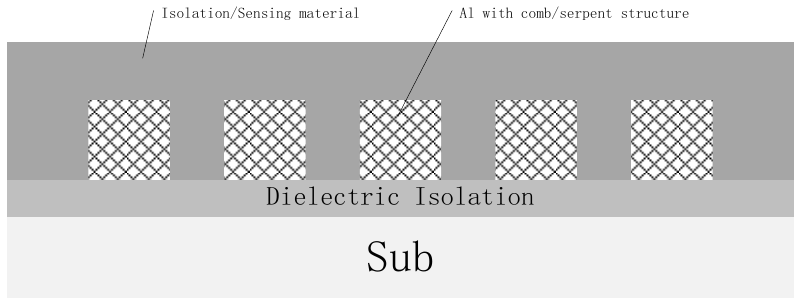
Figure 2. Schematic cross-sectional-view of designed humidity sensor structure.